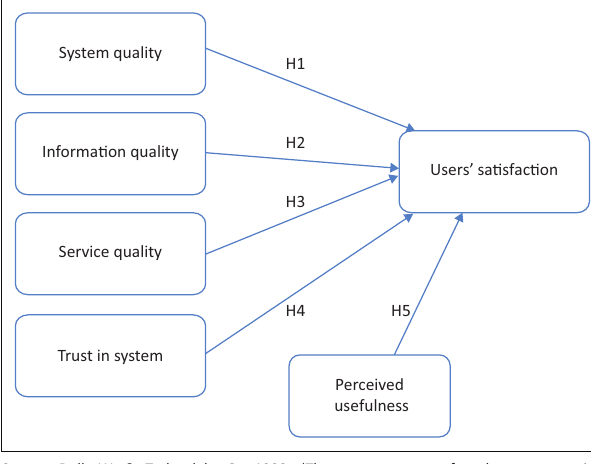
FIGURE 4: The proposed research